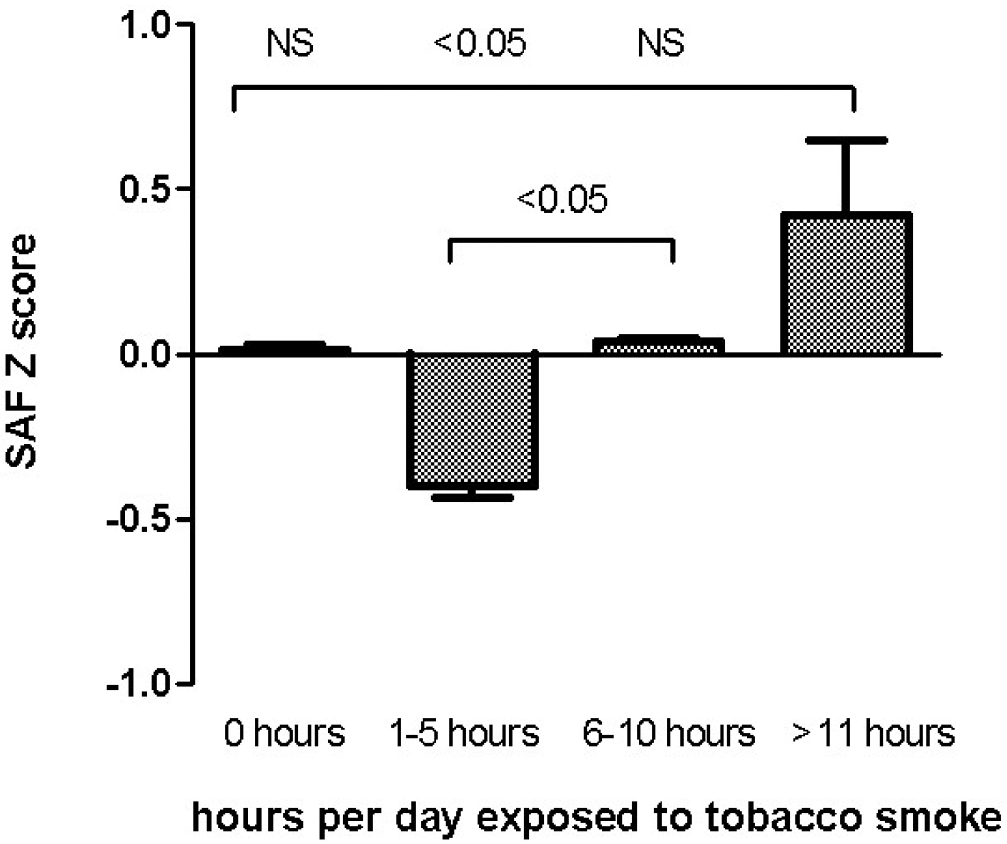
Fig 3. Effect of secondhand smoking on skin autofluorescencein never- and former smokersparticipating in the LifeLines study. Bars represent mean SAF Z scores (adjustedfor age, creatinine clearanceand diabetes status) in never smokers and former smokers who stoppedsmoking for more than 15 years, whiskers reflect standarderror of the mean. 0 hours (n = 4213), 1–5 hours (n = 676), 6–10 hours (n = 78), > 11 hours (n = 15). SAF, skin autofluorescence; Arbitrary Units, AU; NS, not